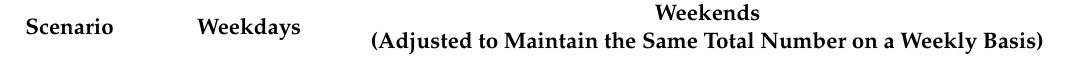
Table 1. Leveling numbers of acute care beds for ED patients.